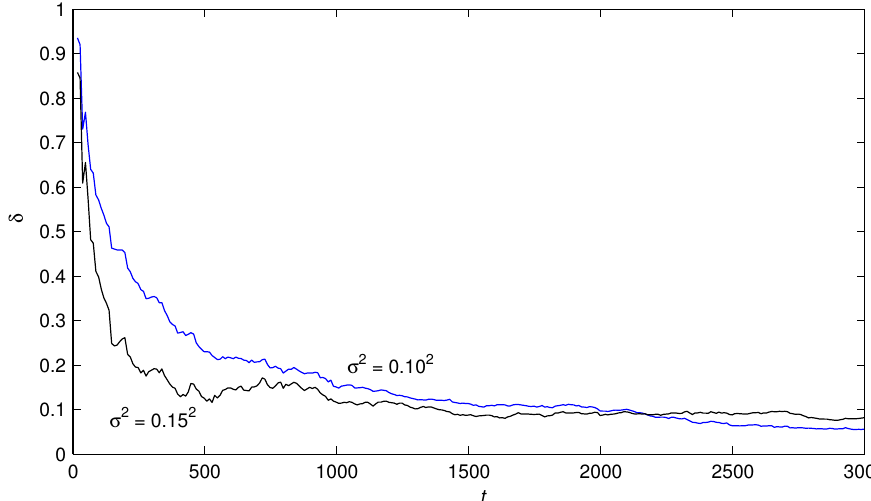
Figure 2. The RGLS parameter estimation errors δ versus t with different variances.